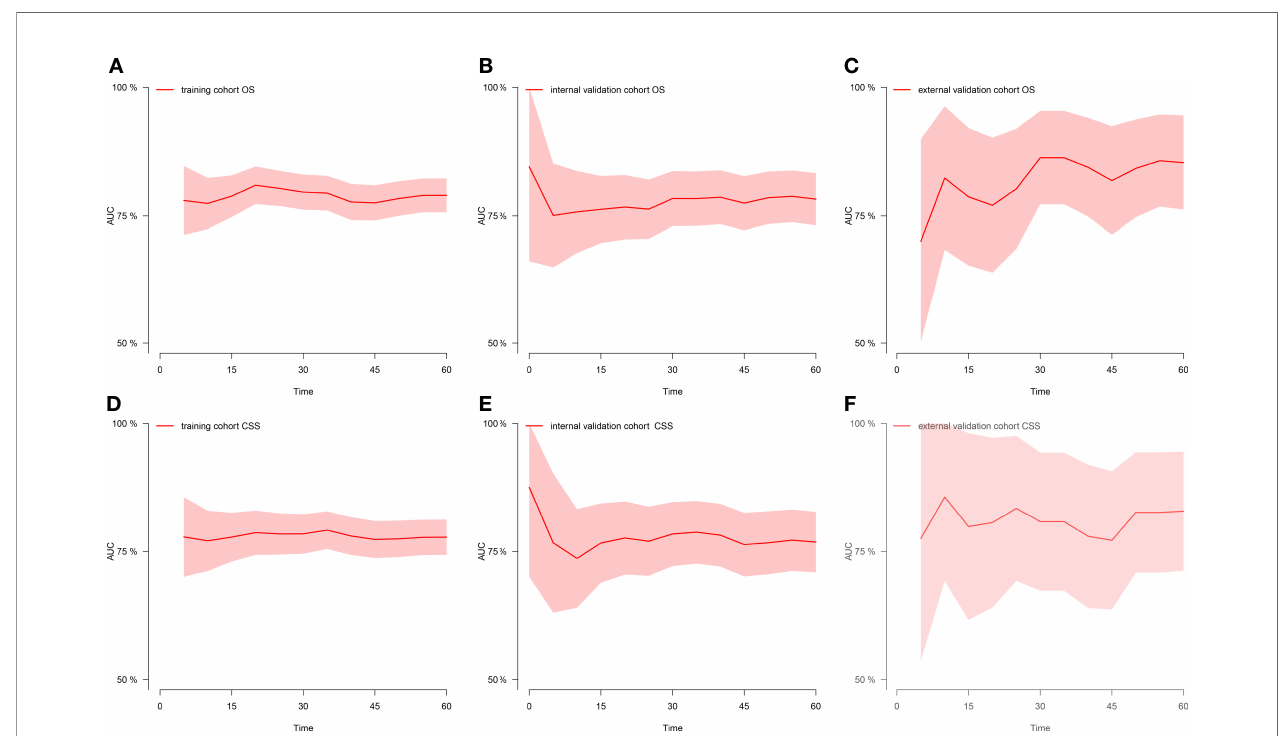
FIGURE 3 | Time-dependent AUC at each time point. (A) Time-dependent AUC of OS in the training cohort. (B) Time-dependent AUC of OS in the internal validation cohort. (C) Time-dependent AUC of OS in the external validation cohort. (D) Time-dependent AUC of CSS in the training cohort. (E) Time-dependent AUC of CSS in the internal validation cohort. (F) Time-dependent AUC of CSS in the external validation cohort. AUC, the area under the curve value of the receiver operating characteristic; OS, overall survival; CSS, cancer-speci fi c